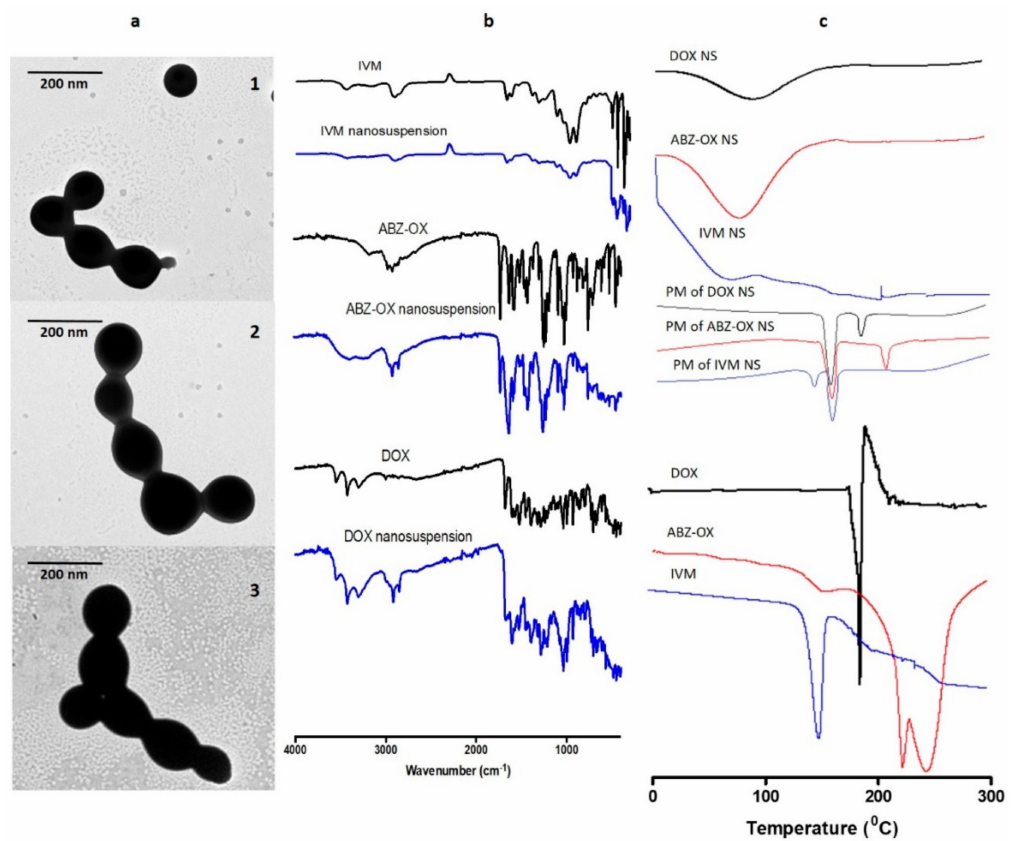
Figure 3. Transmission electron microscope (TEM) images of the NS of ( a.1 ) DOX; ( a.2 ) ABZ-OX; and ( a.3 ) IVM at a magnification power of 30,000 × . ( b ) Nanoparticles were imaged using a JEOL JEM-1400Plus transmission electron microscope, kV = 80. Fourier transform infrared (FTIR) spectra of DOX, ABZ-OX, IVM, and their NS formulations. ( c ) Di ff erential scanning calorimetry (DSC) thermogram of DOX, ABZ-OX, IVM, and their respective physical mixture (PM) and NS